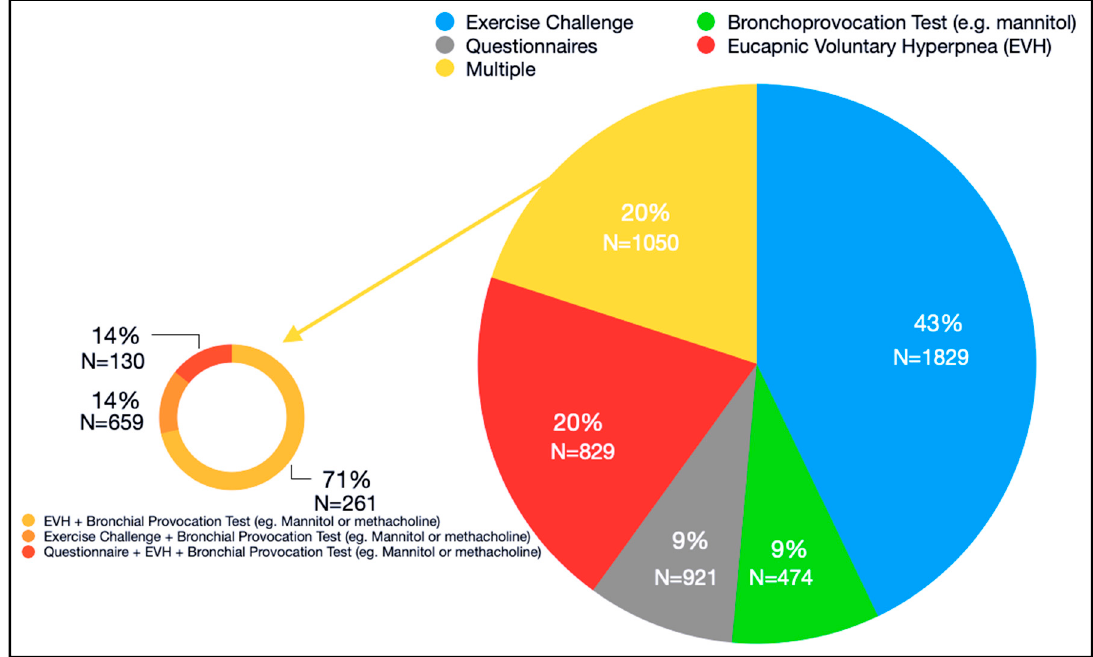
Figure 2. Screening process and classification of articles by sex reporting. RCT: randomized controlled trial; CT: clinical trial.